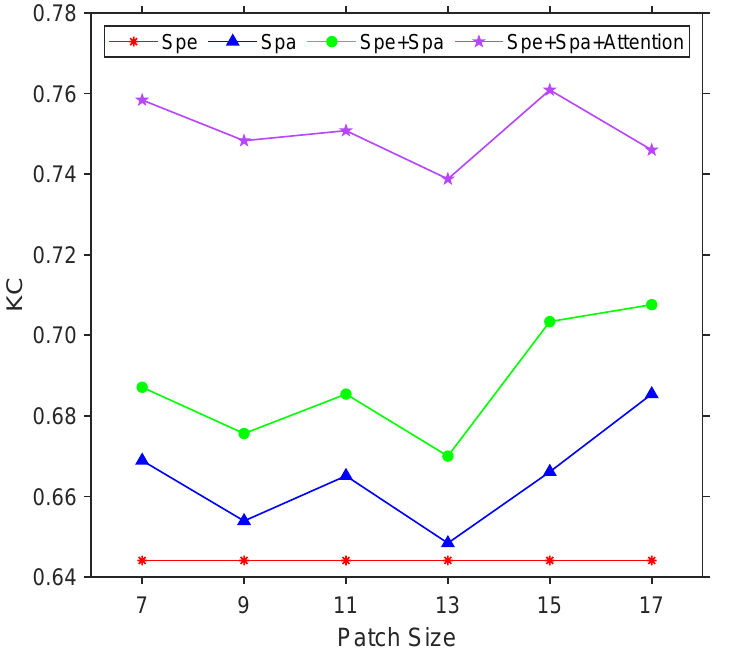
Figure 6. Sensitivity analysis of patch size for each component of the proposed ASSCDN on the River dataset.